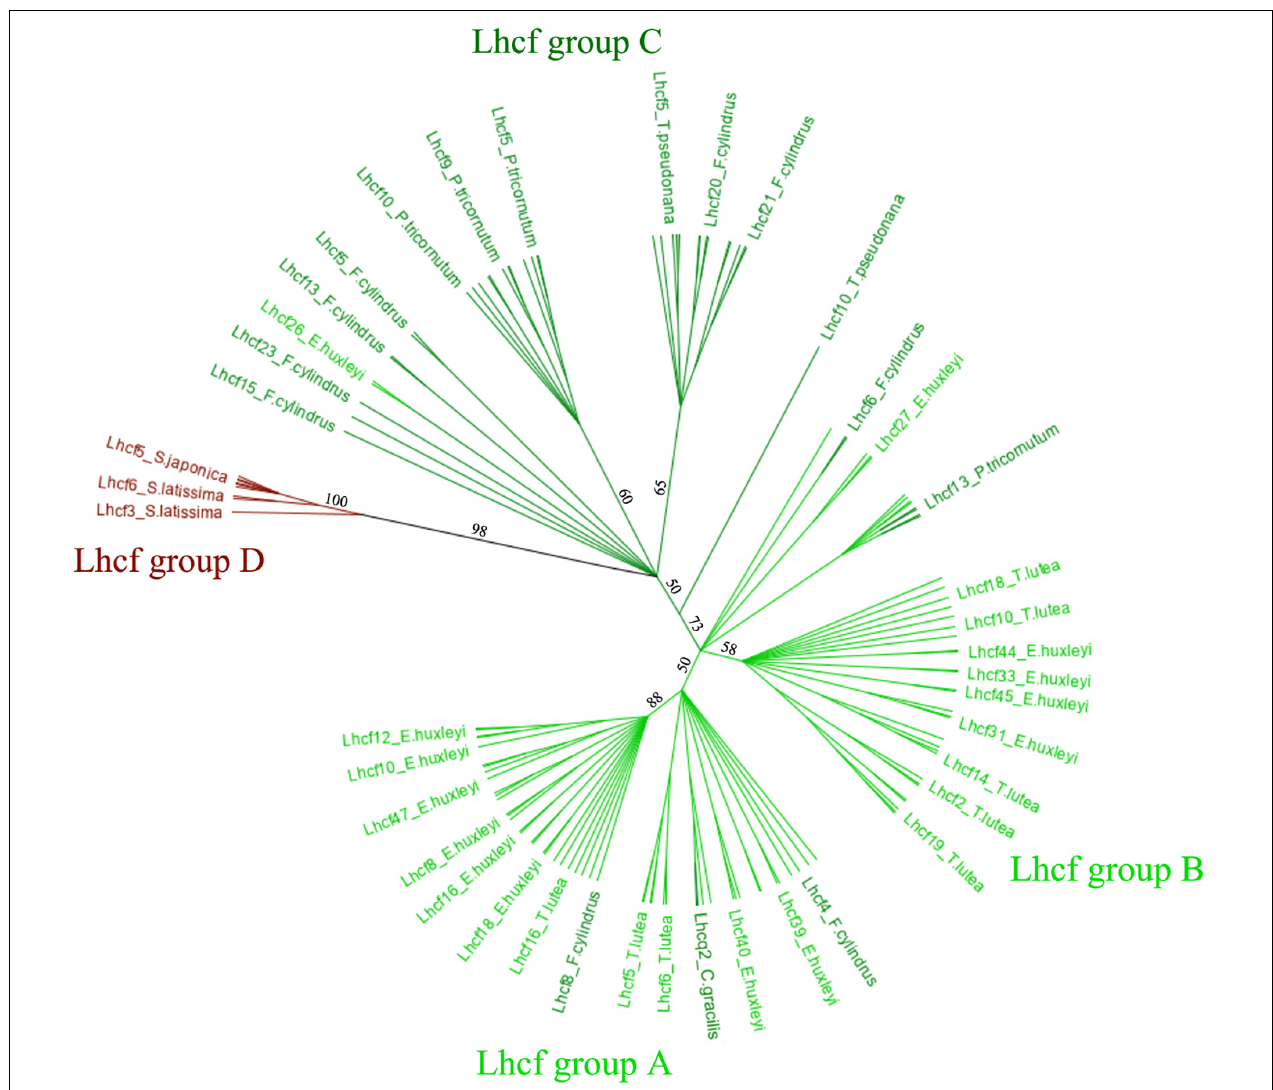
FIGURE 2 | Cladogram of the 134 Lhcf sequences of eight species, Phaeodactylum tricornutum, Fragiliaropsis cylindrus, Thalassiosira pseudonana, Chaetocerosgracilis, Saccharina japonica, Saccharina latissima, Emiliania huxleyi, and Tisochrysis lutea . Light green: haptophyte Lhcf. Dark green: diatom Lhcf. Dark red: seaweed